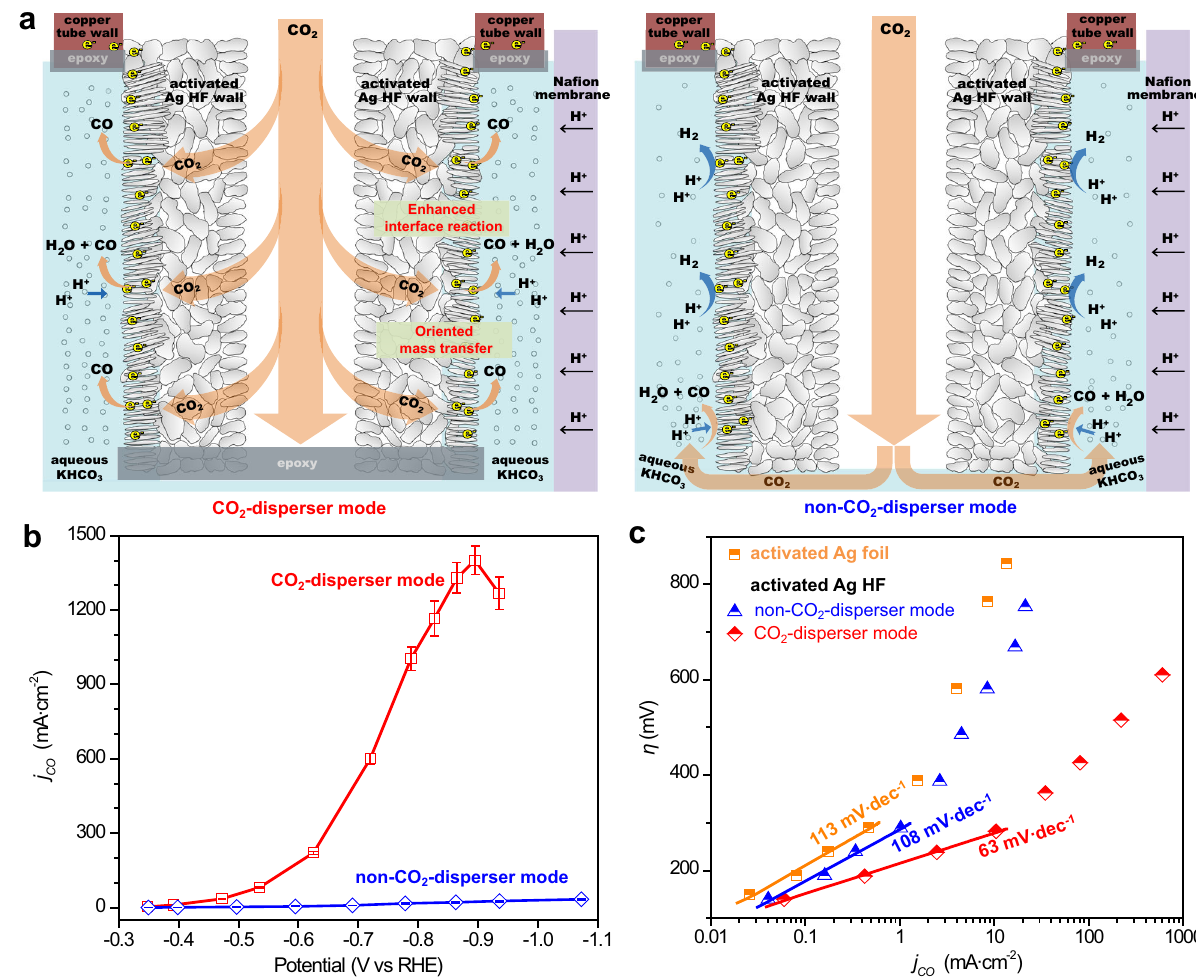
Fig. 5 CO 2 dispersion effect studies. a Schematic illustrations showing the processes of CO 2 electroreduction over activated Ag HF with the CO 2 - disperser mode and the non-CO 2 -disperser mode, respectively, and b , their CO partial current densities. Error bars in b were obtained from the average of six individual tests. c Tafel slopes of activated Ag foil and activated Ag HF with different dispersion